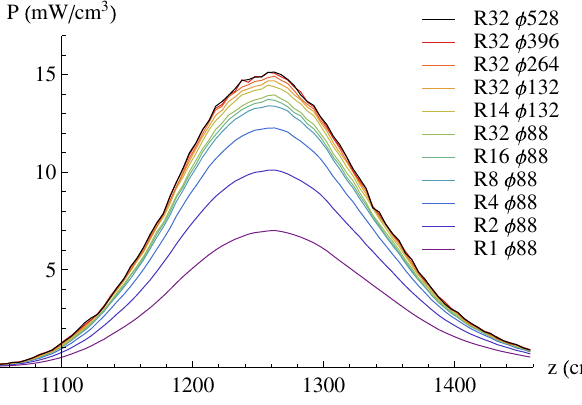
FIG. 8. (Color) The linear power density along z caused by BFPP in the inner layer of the coil of the dipole magnet for varying radial and azimuthal binnings, where Ri(cid:11)j stands for i radial bins and j azimuthal bins. In all cases, we used a longitudinal cell size of (cid:1) z ¼ 5 cm . The hottest bin was selected for each mesh.